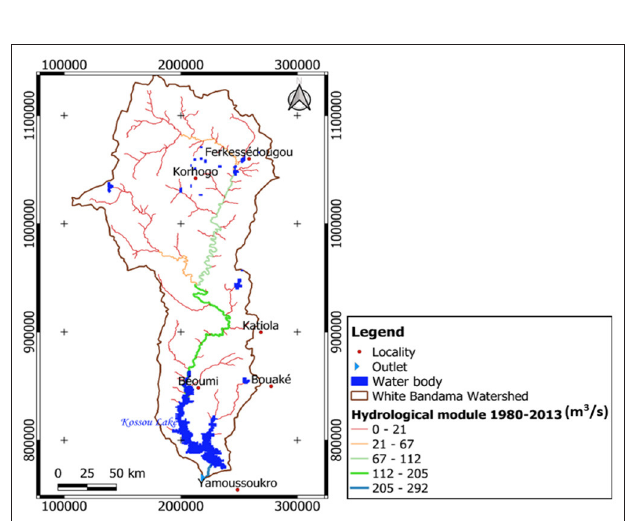
FIGURE 9 | Assessment of the hydrological module of the WBW from 1980 to 2013.